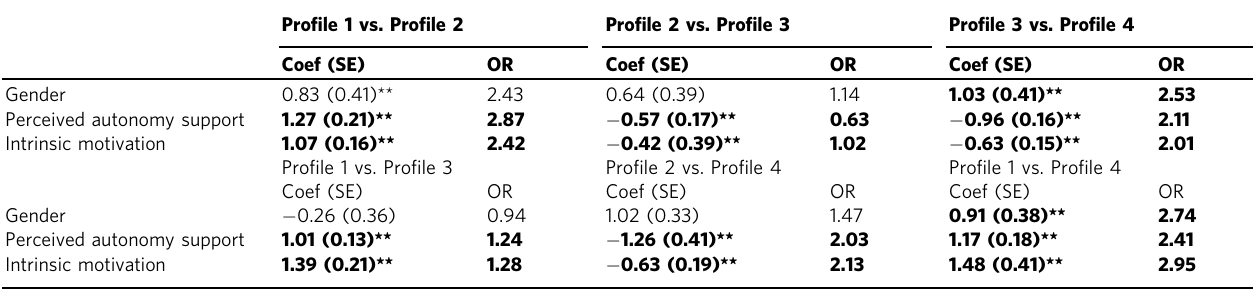
Table 7 Results from multinomial logistic regressions of predictors of pro fi le